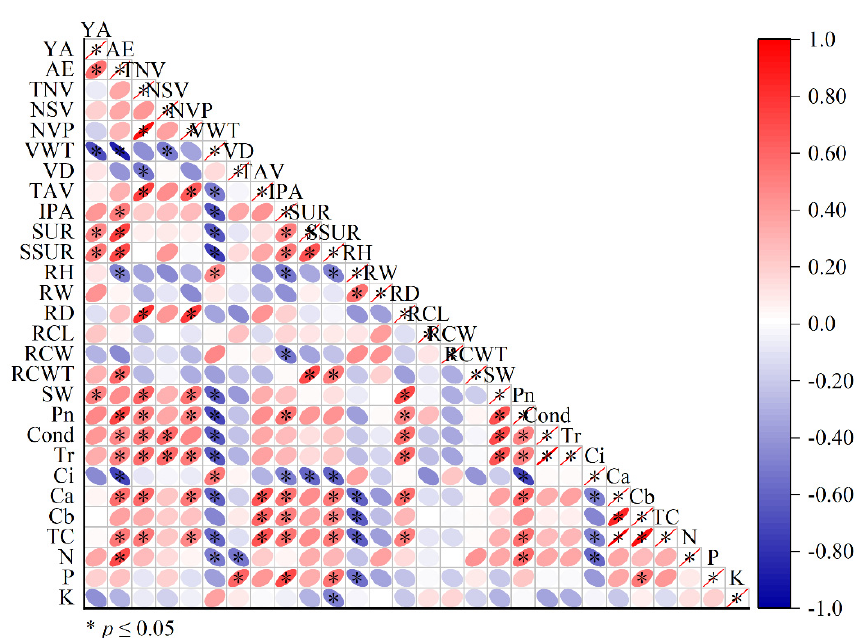
Figure 7. Correlation analysis of various indicators in OA and Qi-Nan. Note: “YA” yield of agar- wood; “AE” agarwood ethanol extract ; “TNV” total number of vessel; “NSV” number of single vessels; “NVP” number of vessels in pairs; “VWT” vessel wall thickness; “VD” vessel diameter; “TAV” total area of vessel; “IPA” interxylary phloem area; “SUR” starch utilization rate; “SSUR” soluble sugar utilization rate; “RH” ray height; “RW” ray width; “RD” ray density; “RCL” ray cell length; “RCW” ray cell width; “RCWT” ray cell wall thickness; “SW” specific leaf weight; “Pn” net photosynthetic rate; “Cond” stomatal conductance; “Tr” transpiration rate; “Ci” intercellular CO 2 concentration; “Ca” chlorophyll a, “Cb” chlorophyll b, “TCa + b” total chorophyll; “N” nitrogen; “P” phosphorus; “K” potassium content in leaves.